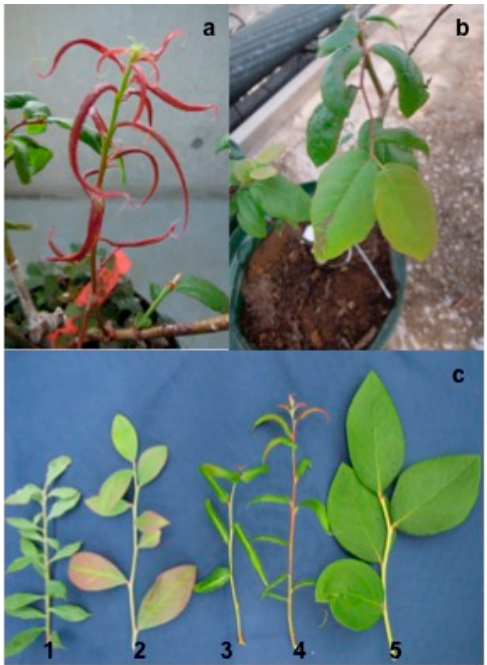
Figure 1. Blueberry shoestring virus (BSSV)-like symptoms in grafted blueberry seedlings three years after graft inoculations were performed. ( a ) The blueberry leaves are red and are narrow; ( b ) The main vein of the blueberry leaf has changed to red and there is deformation of the leaf; ( c ) 1–4: Appearance of blueberry seedlings grafted with different BSSV-infected scions. 5: Healthy blueberry leaf.